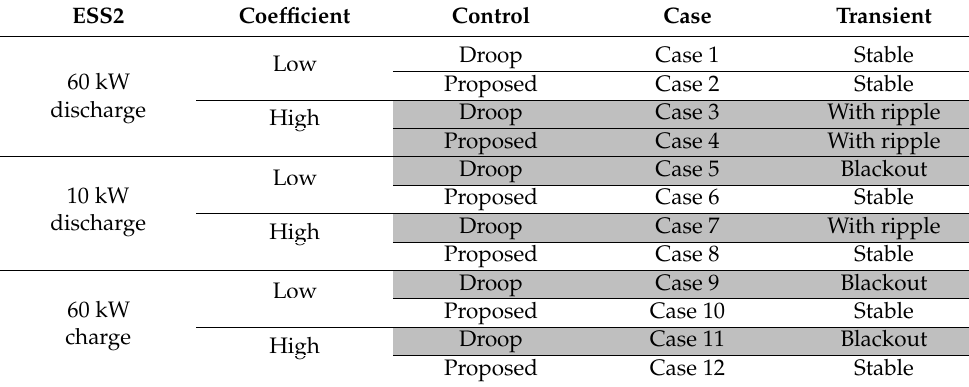
Table 1. Simulation conditions and results.